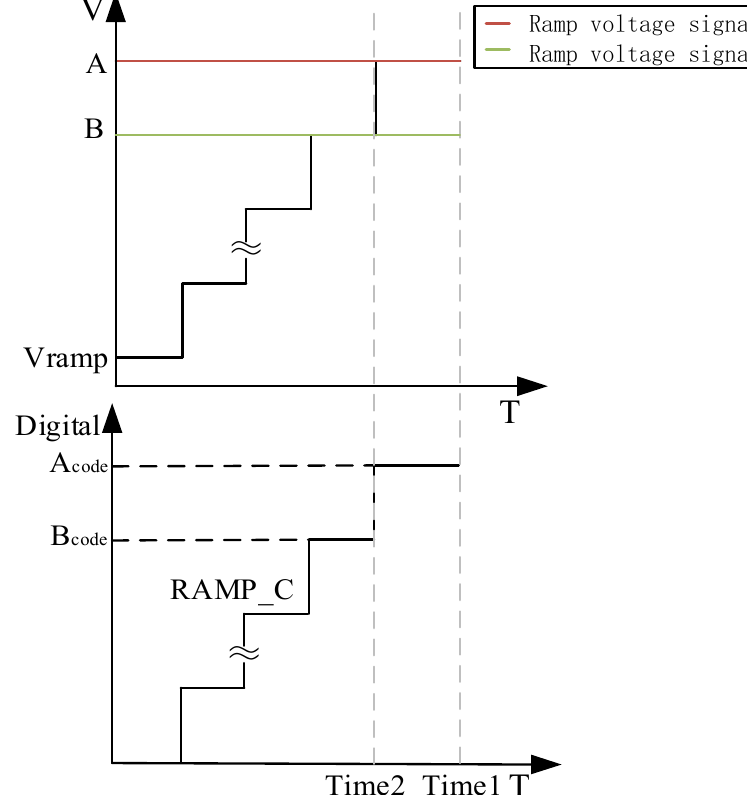
Figure 3. Schematic diagram of time difference conversion.